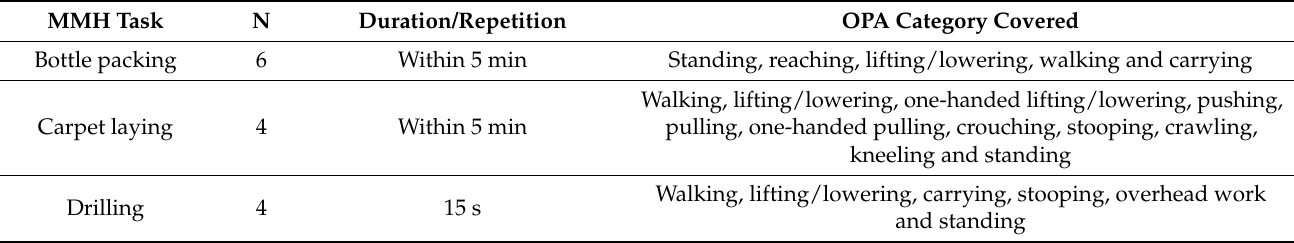
Table 2. Manual material handling tasks ( n = 9). Subjects complete MMH tasks with different handling height and OPAs covered by each task are